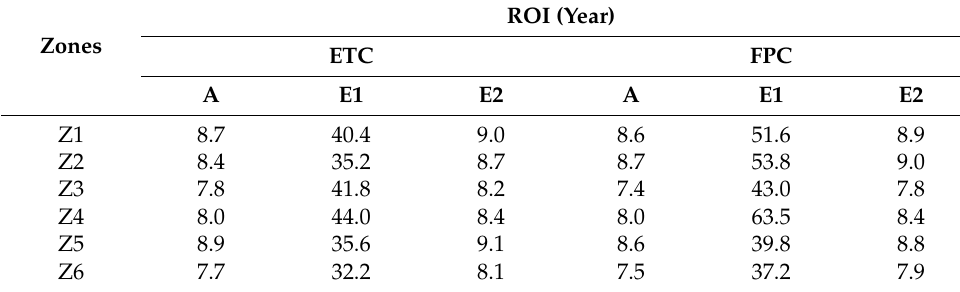
Table 21. Return on investment time of collective solar water heaters.